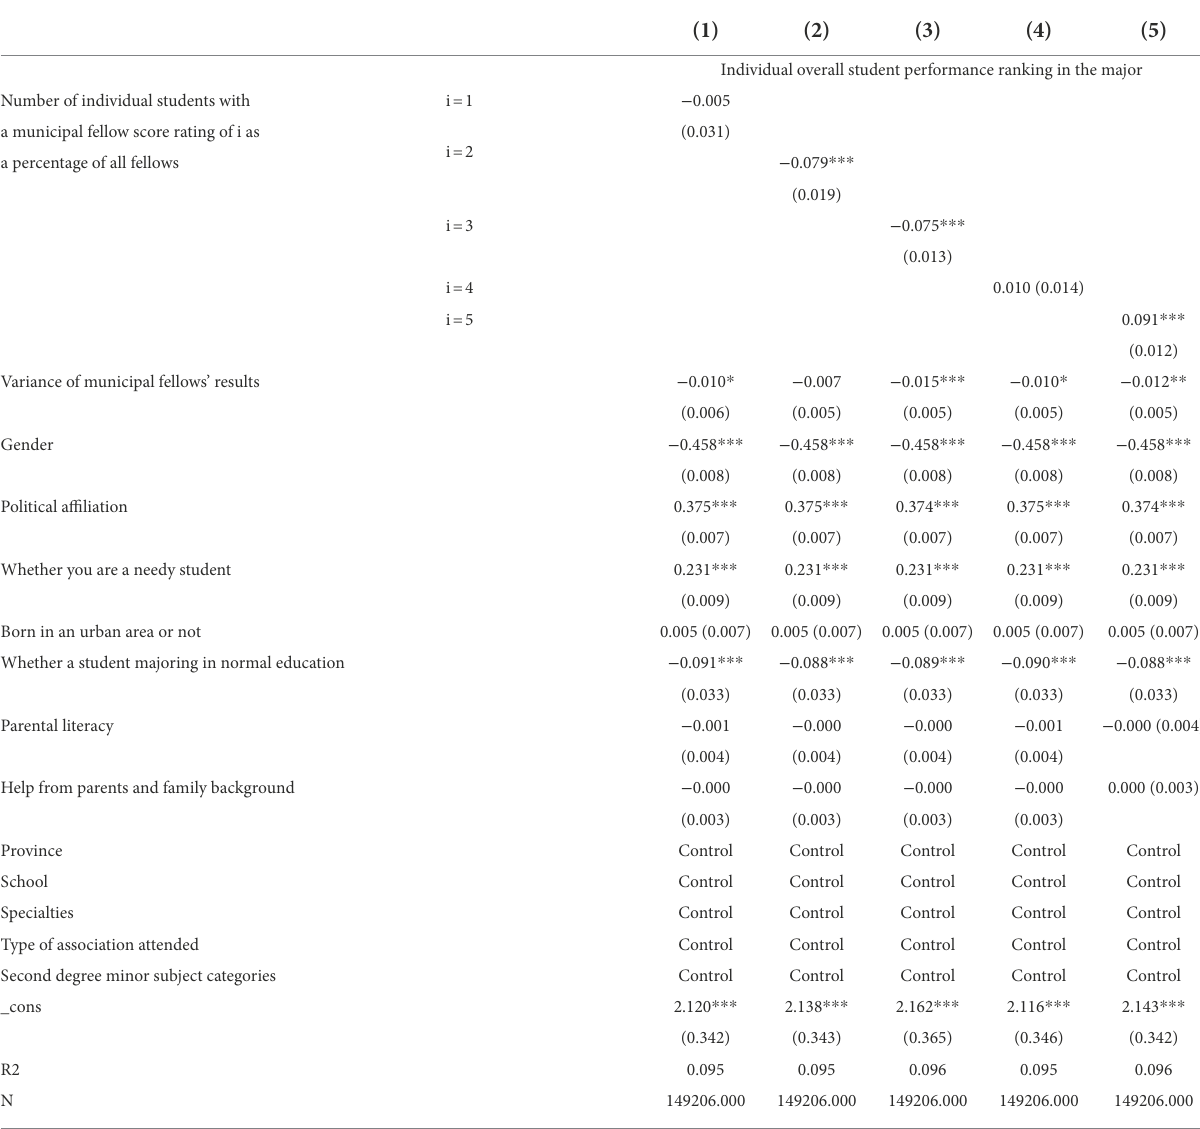
TABLE 8 Robustness